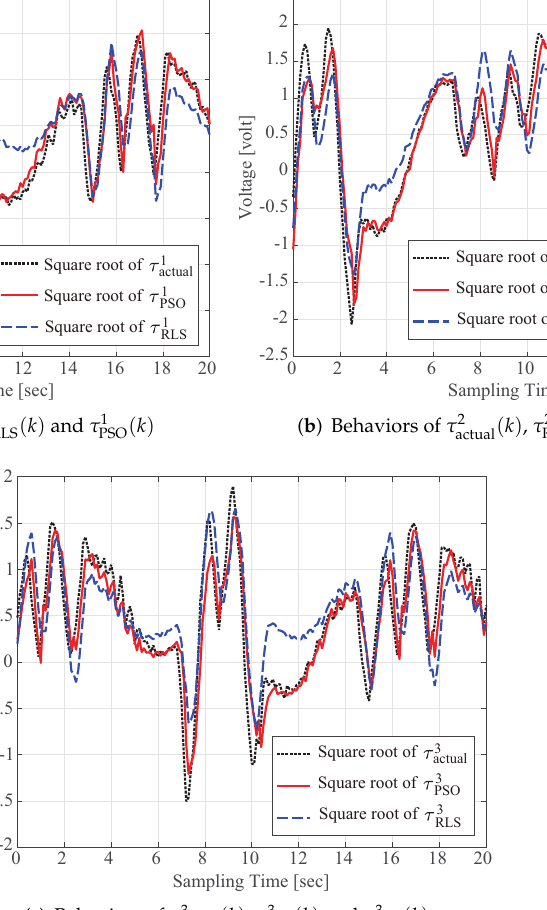
( k ) computed using (26) with the identified parameter values PSO